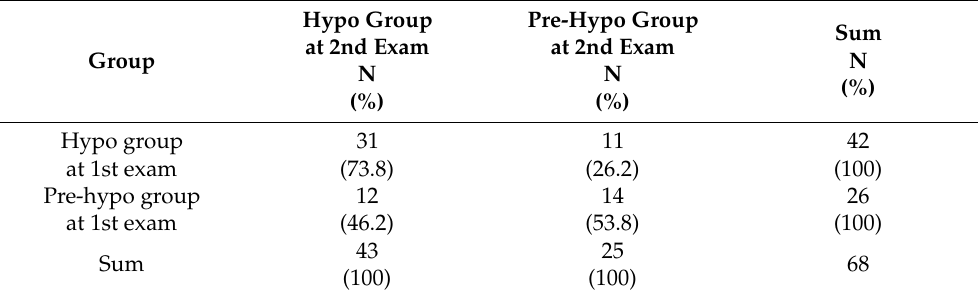
Table 5. Prevalence rate of oral hypofunction in the first and second examination. Hypo Group